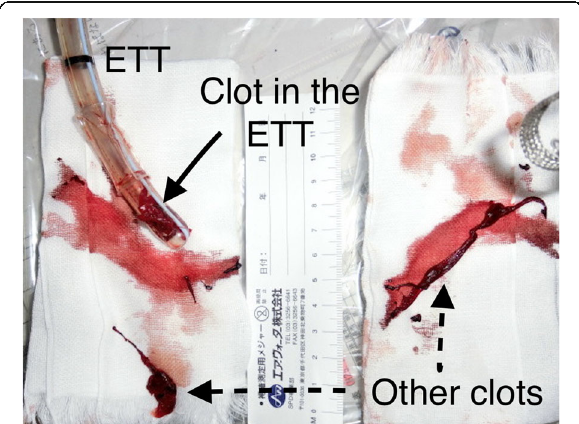
Fig. 1 Removed clot and endotracheal tube. The removed clot lodged within the endotracheal tube ( black arrow ); the remaining clot ( dotted arrow ) removed by suction under fiberoptic bronchoscopy. ETT